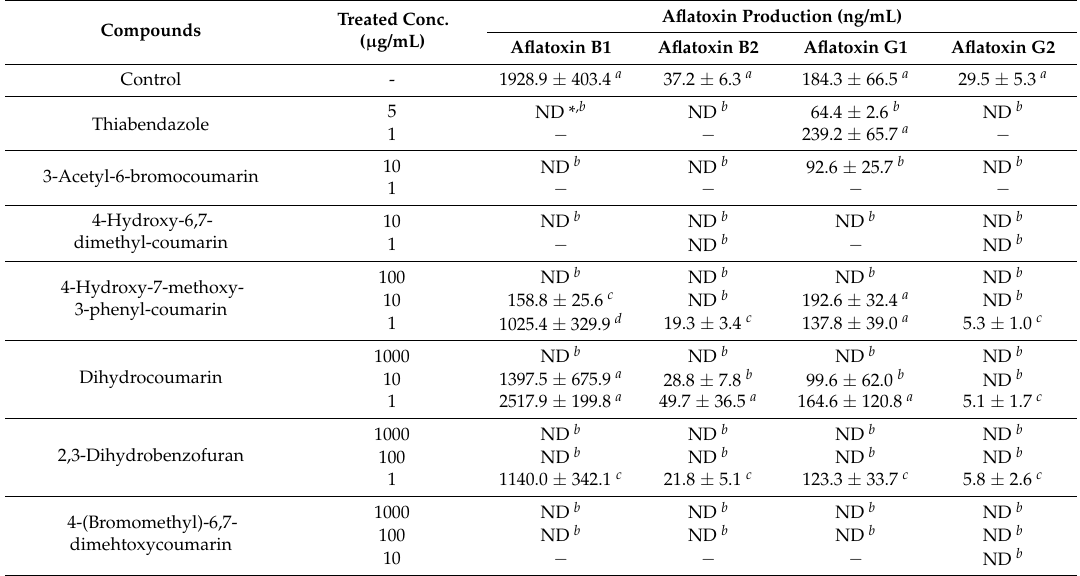
Table 2. Inhibitory effects of coumarins on aflatoxin production in Aspergillus flavus.